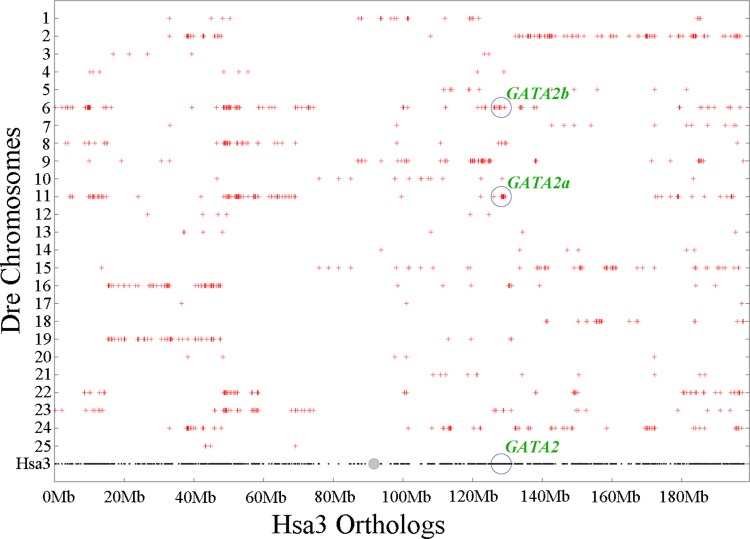
Chromosome synteny analysis of teleost GATA2 paralogs.Dotplots of the human GATA2 gene region on human chr3 show double conserved synteny to the two GATA2 paralogs in zebrafish on chromosomes Dre6 (GATA2b) and Dre11 (GATA2a).